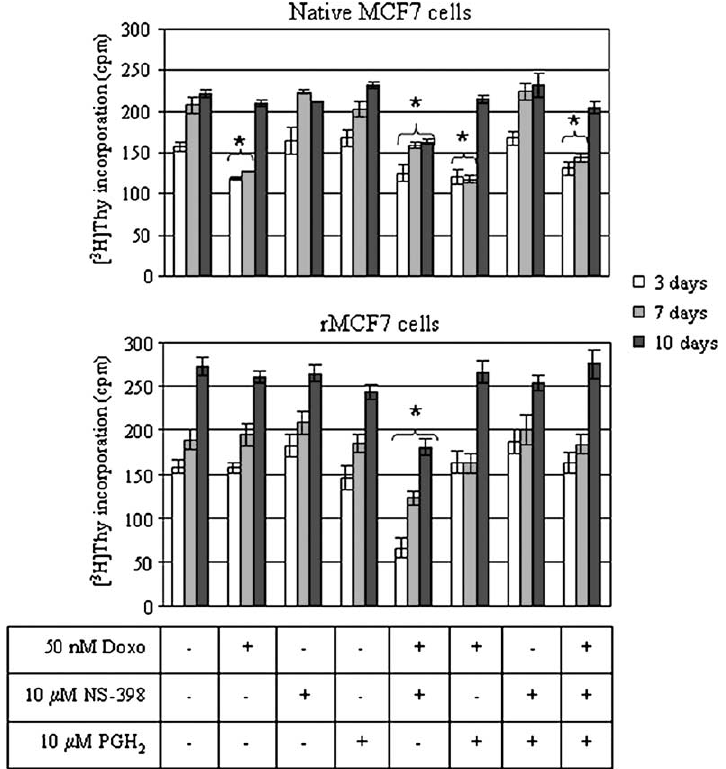
Fig. 1. Effects of PGH 2 on MCF7 cell proliferation. Native MCF7 and rMCF7 cells were incubated in 24-well plates up to 10 days in the presence of [ 3 H]thy in culture medium supplemented without or with 50 nM Doxo, 10 µM NS-398, 10 µM PGH 2 alone or in combination and then DNA synthesis was evaluated. Data from three individual experiments evaluated independently with four replicates are expressed as the mean ± SE [ 3 H]thy incorporation (cpm). * p < 0 . 05 vs. control untreated